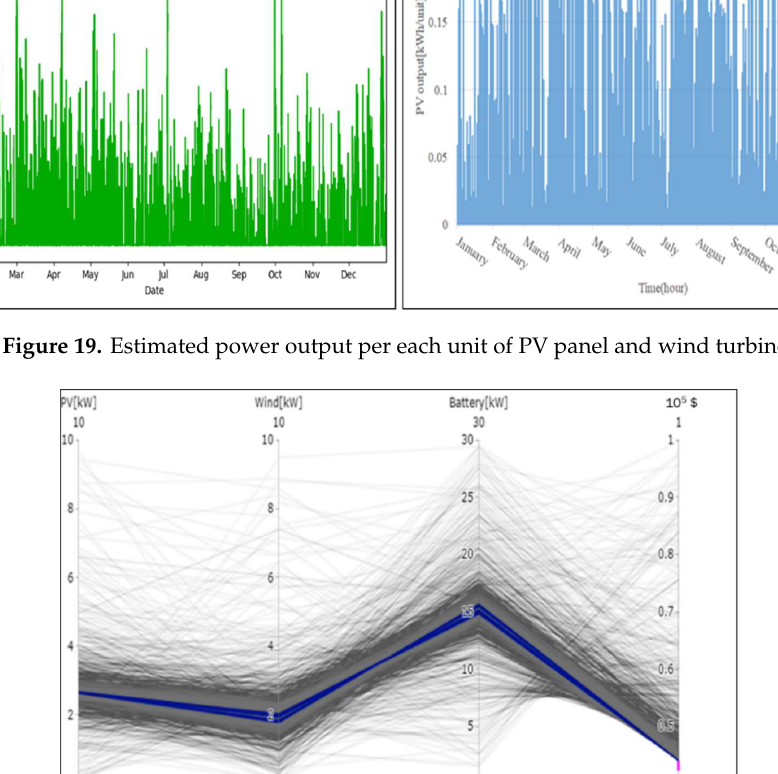
Figure 20. Pathways towards the optimal solution by the PSO model. Table 5. Cost analysis of the system.